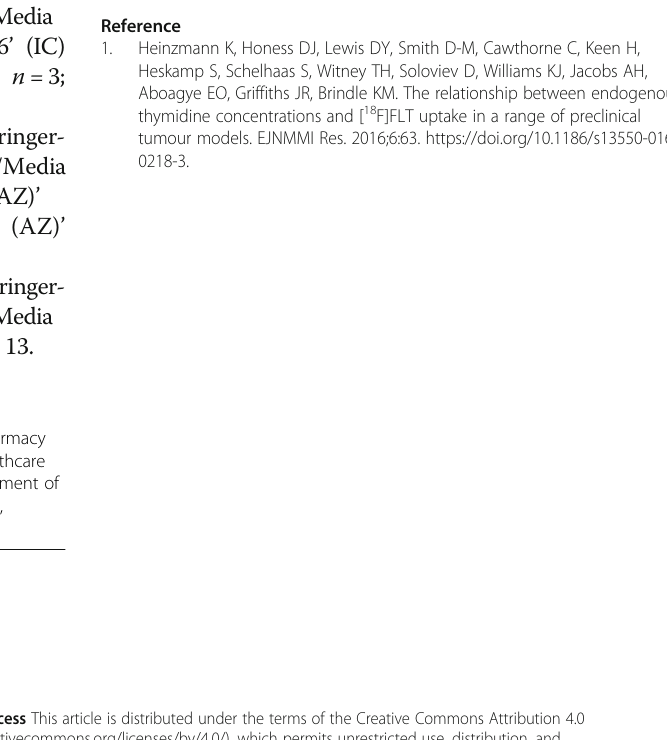
Figure 4 (http://media.springernature.com/full/springer-